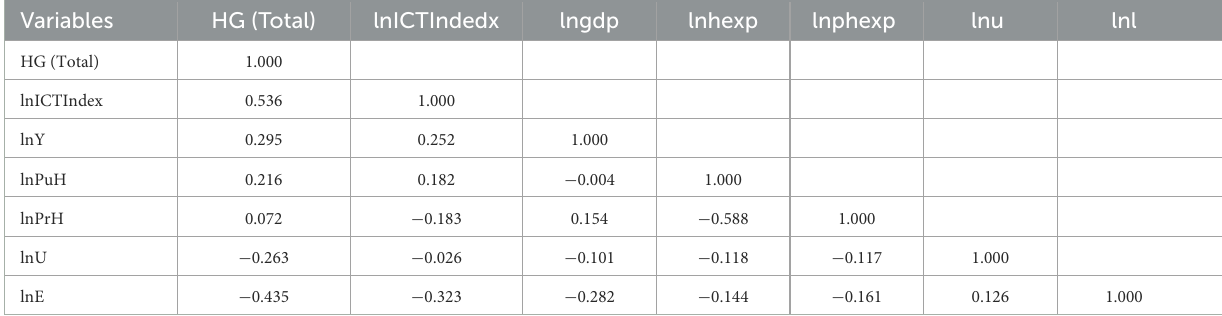
TABLE 4 Correlation matrix for life expectancy at